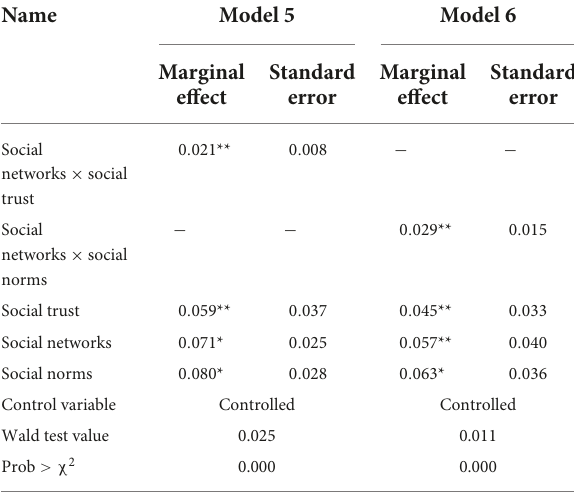
TABLE 7 Estimated results of the impact of social capital interaction terms on farmers’ green control technology (GCT) adoption behavior (instrumental variable